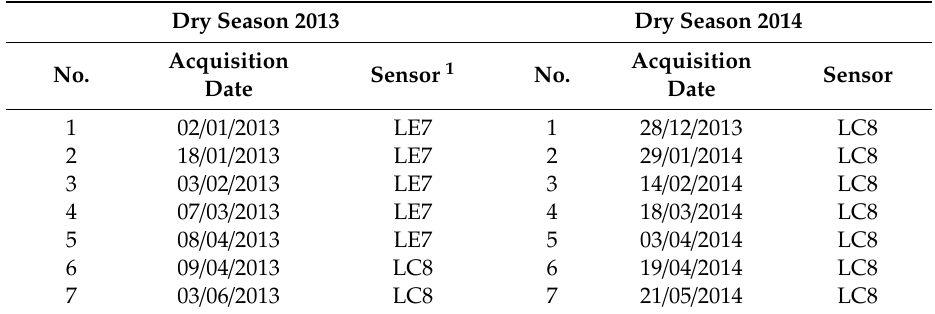
Table 1. Landsat images from scene P197R052 used for assessing irrigation performance in the Kou Valley irrigation scheme during the study period